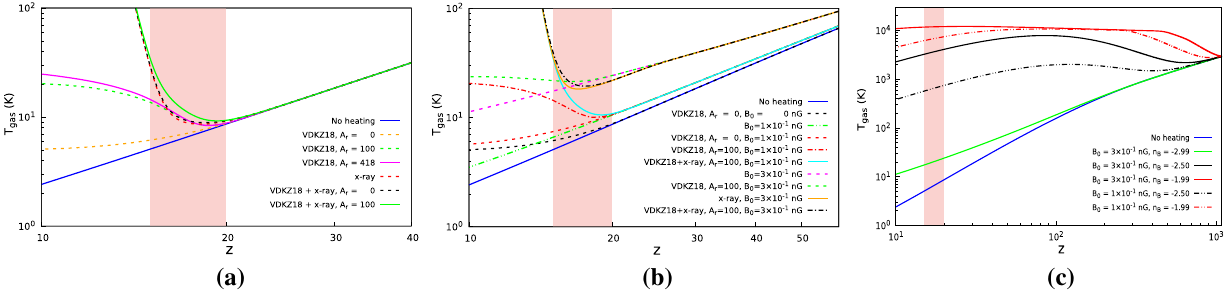
a , we consider only VDKZ18 and X-ray heating with excess radiation ( A r ). In figure b , we include different combination of VDKZ18, X-ray and magnetic heating, and spectral index is fixed to − 2.99. In figure c , we vary the spectral index and plot magnetic heating of the